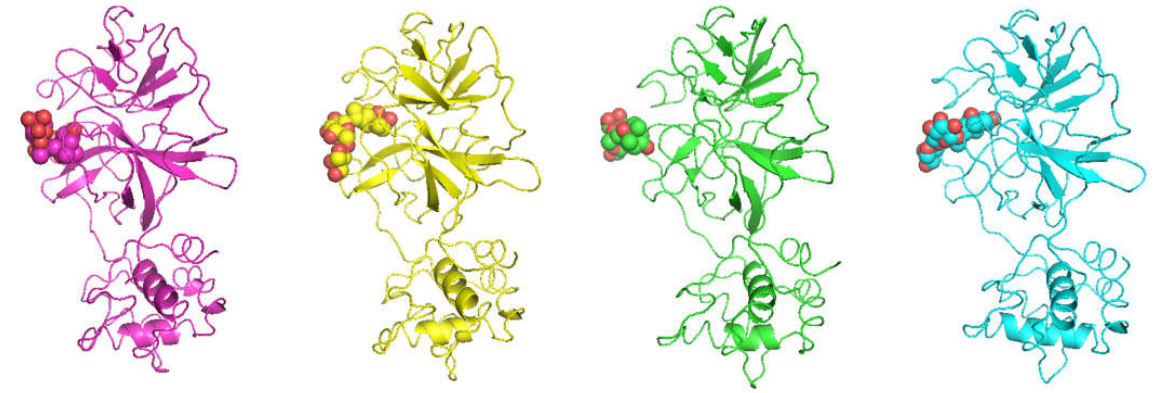
Figure 1. Wild-type and Omicron M pro variants in complex with the L01 and L02 compounds. The protein structures are shown in cartoon and the compounds in spheres with the following scheme color: magenta: L01 - M pro WT (W1), yellow: L02 - M pro WT (W2), green: L01 - M pro O (O1), cyan: L02 ─ M pro O (O2).